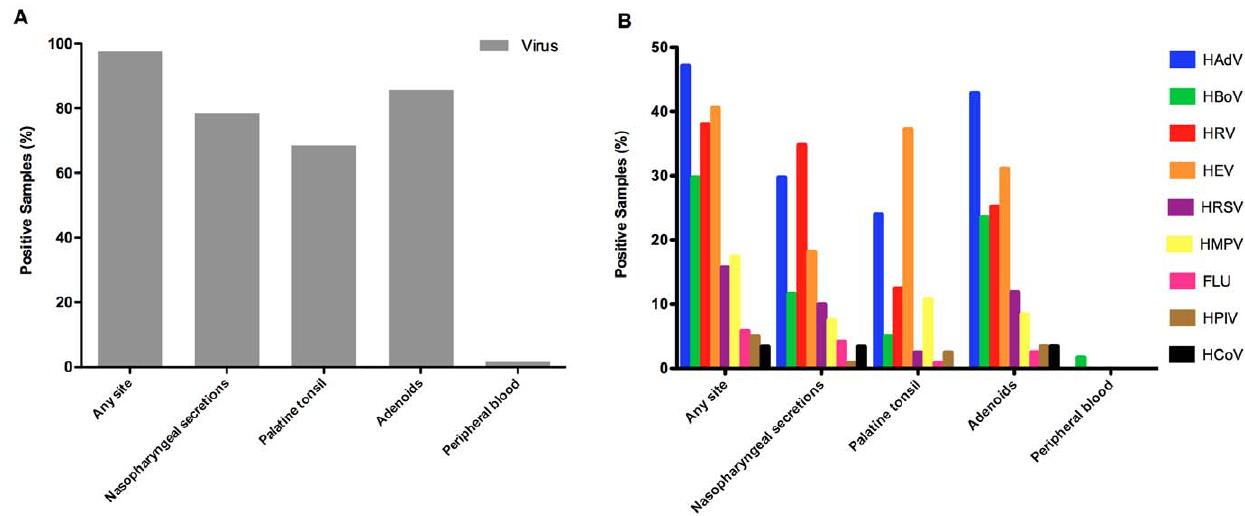
Figure 1. Frequencies of virus detection in patients with chronic adenotonsillar diseases. ( A ) Overall frequencies of virus detection by qPCR in different sample sites of 121 patients with chronic adenotonsillar disease. ( B ) Frequencies of detection of each tested virus by qPCR at different sites in 121 patients with chronic adenotonsillar disease.